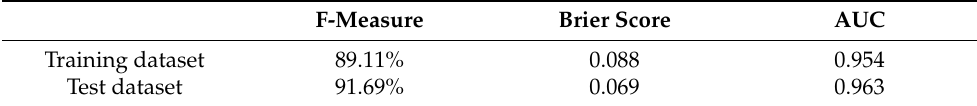
Table 8. Predicted performance of the best model.